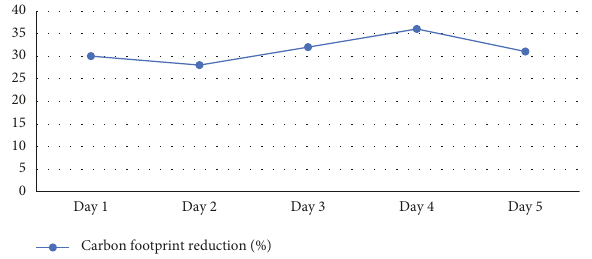
Figure 6: Reduction in carbon